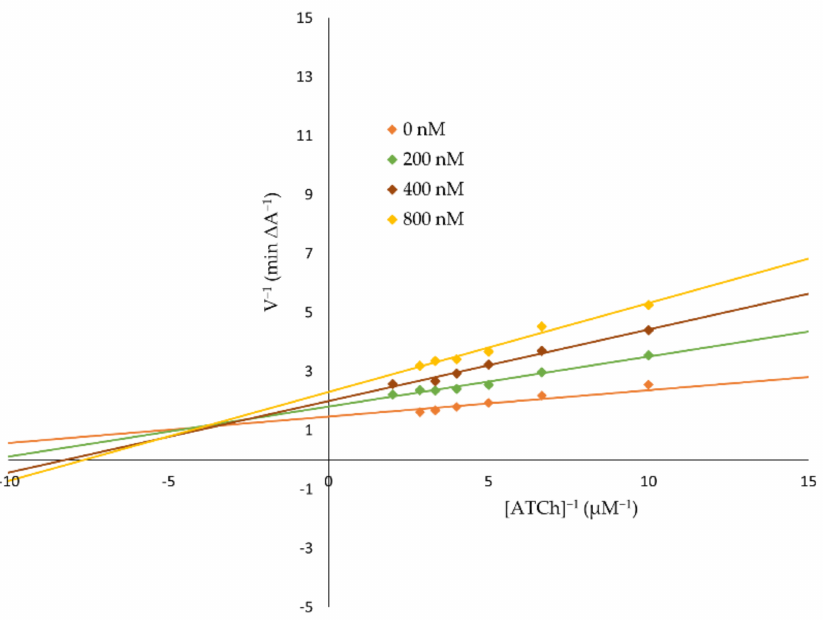
Figure 1. A Lineweaver-Burk plot presenting a mixed-type of AChE inhibition by 3f